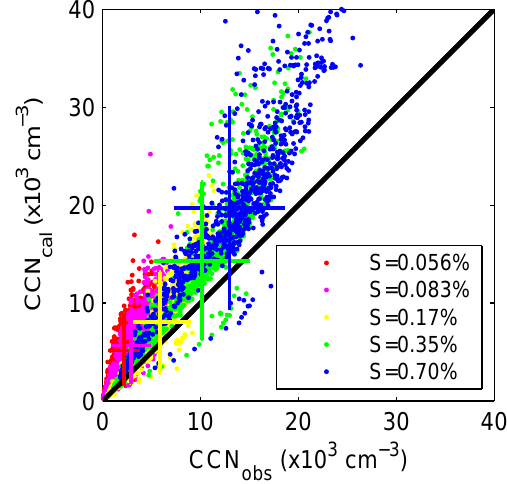
Fig. 1. Comparison between the calculated and observed CCN num- ber concentration during 31 December 2009 and 20 January 2010 at Wuqing. The composition of aerosol is assumed to be pure ammonium sulfate and the water accommodation coefficient is 0.04. Different colours represent different supersaturations (red: S = 0 . 056%; pink: S = 0 . 083%; yellow: S = 0 . 17%; green: S = 0 . 35%; blue: S = 0 . 70%). The centre of the cross represents the mean calculated CCN concentration and the mean observed CCN concentration at each supersaturation. Horizontal and vertical bars indicate the standard deviations of the observed CCN and calculated CCN concentrations,